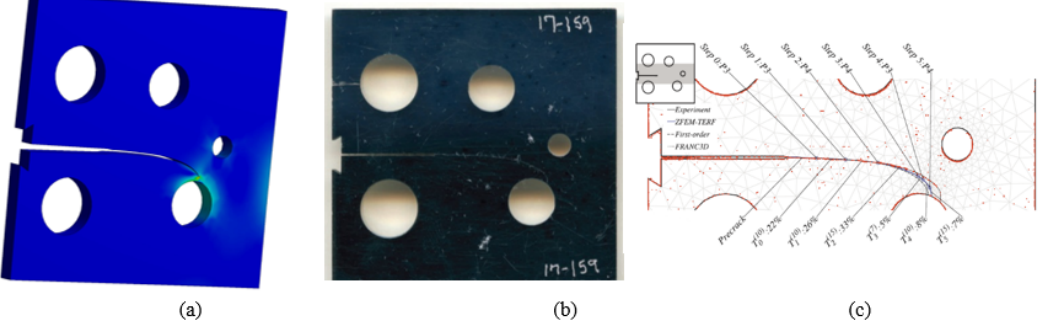
Figure 5. Specimen 2, crack propagation path ( a ) ANSYS results, ( b ) experimental results [46], and ( c ) numerical results [47].